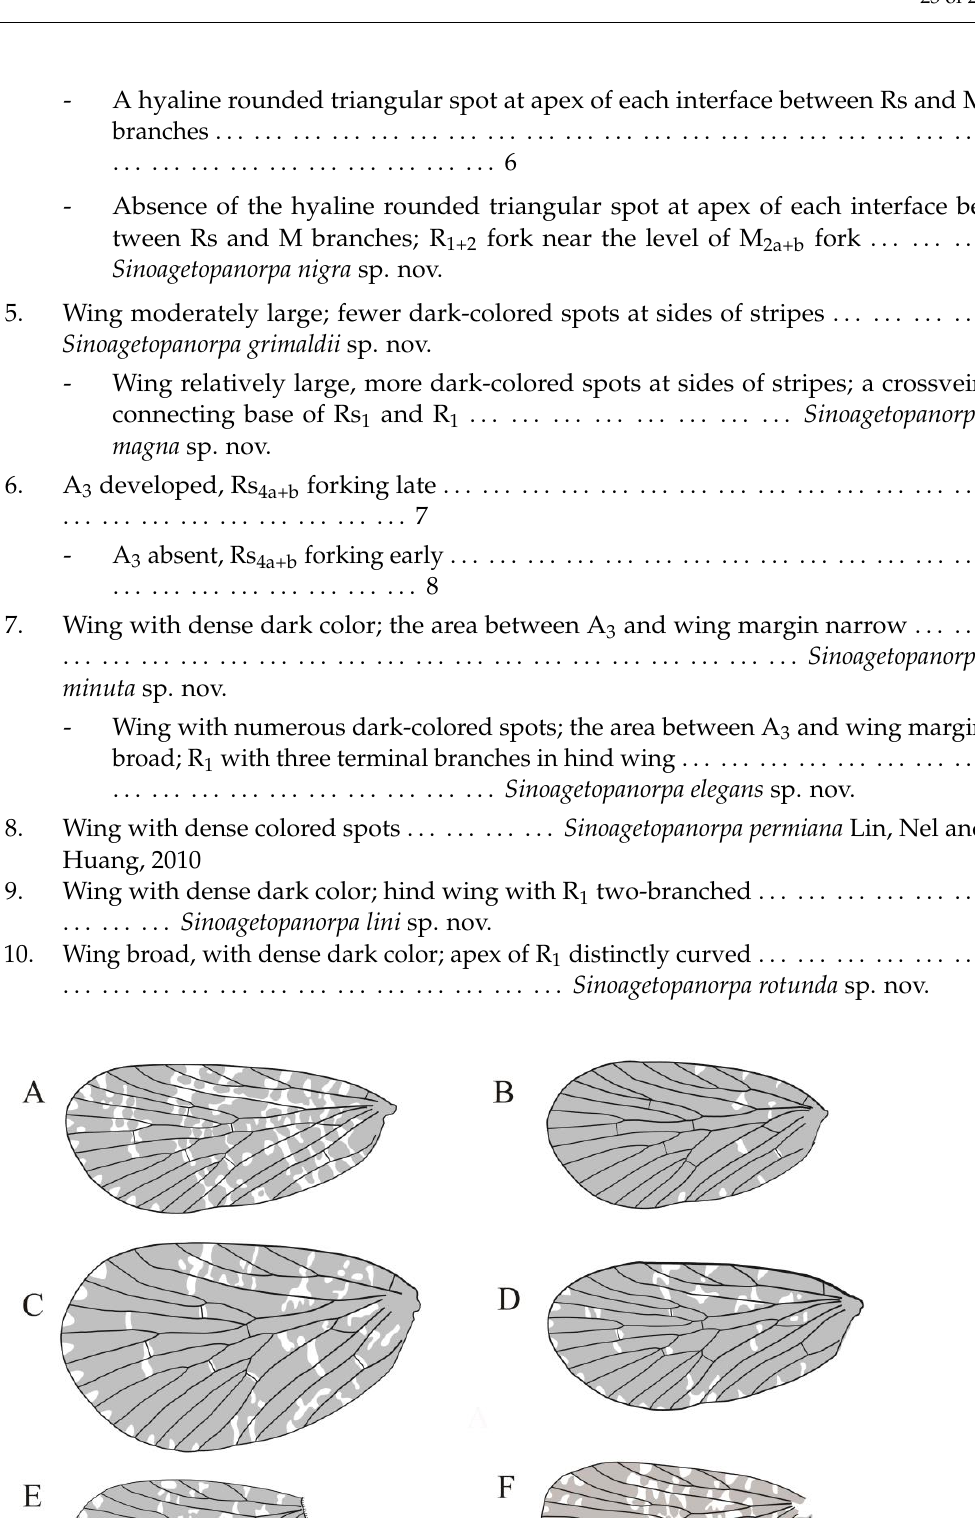
Figure 19. Line drawings of all sinoagetopanorpid species: ( A ) Sinoagetopanorpa permiana Lin, Nel and Huang, 2010, NIGP200888 (paratype); ( B ) S . nigra sp. nov., NIGP200912 (holotype); ( C ) S. ro- tunda sp. nov., NIGP200913 (holotype); ( D ) S . lini sp. nov., NIGP200917 (paratype); ( E ) S . minuta sp. nov., NIGP200920 (holotype); ( F ) S . elegans sp. nov., NIGP200921 (holotype); ( G ) S . grimaldii sp. nov., NIGP200922 (holotype) (mirror image); ( H ) S . magna sp. nov., NIGP20926 (holotype); ( I ) Raragetopanorpa zhangi sp. nov., NIGP200927 (holotype); ( J ) Permoagetopanorpa yinpingensis sp. nov., NIGP200928 (holotype); ( K ) P. incompleta sp. nov., NIGP200929 (holotype). Scale bar represents 1 mm. 4. Discussion Sinoagetopanorpidae fam. nov. resemble members of the subfamily Agetopanor- pinae of Permochoristidae in venation. Both groups are characterized by the following